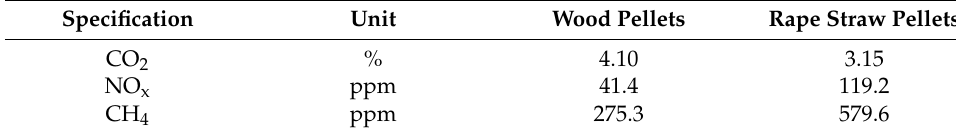
Figure 5. Time course of changes in NO x concentration for combustion tests of wood pellets and rape straw pellets. Table 4. Average concentrations of the measured flue gas components.